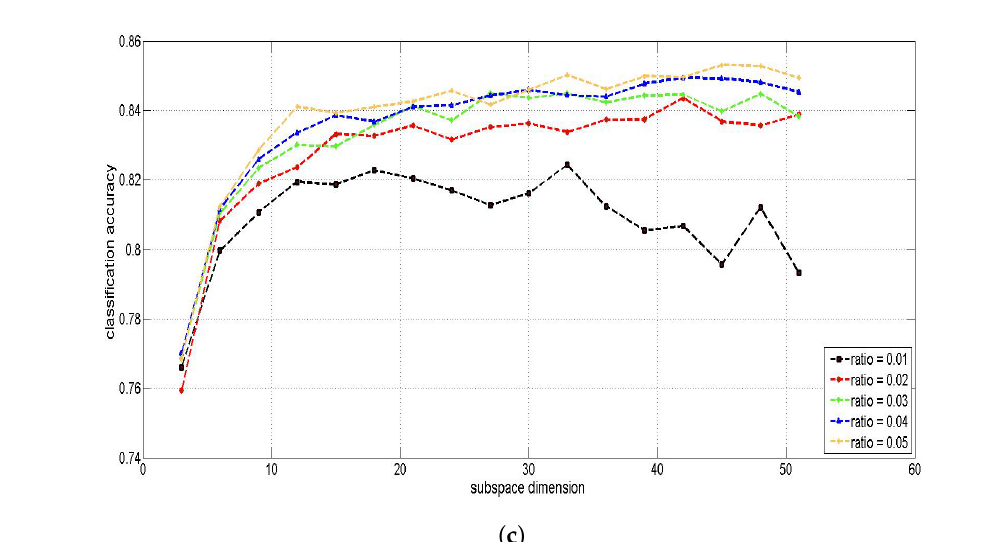
Figure 9. Classification accuracy vs train ratio and subspace dimension. ( a ) Flevoland dataset. ( b ) Foulum dataset. ( c ) San Francisco